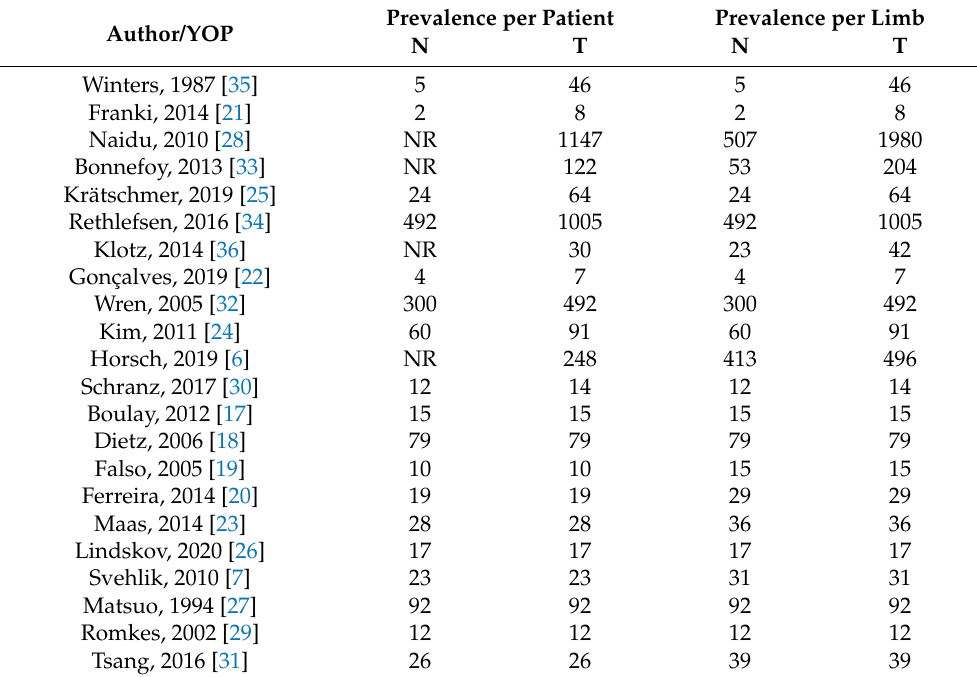
Table 2. Prevalence of equinus foot per patient and per foot among the included studies of patients with cerebral palsy.